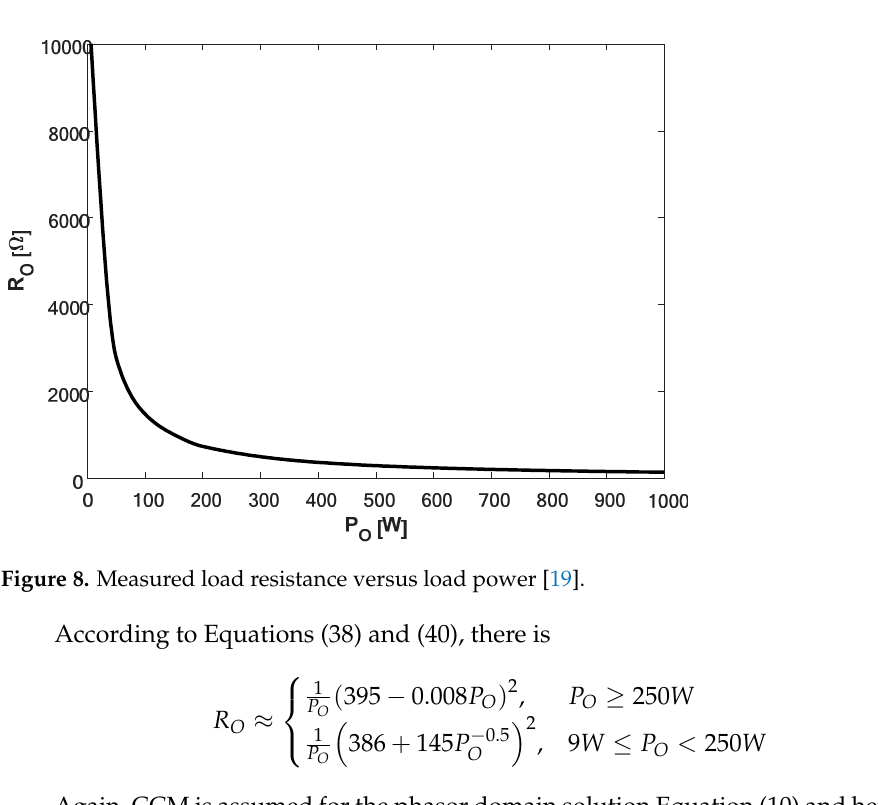
Figure 7. Measured output voltage versus load power [19].